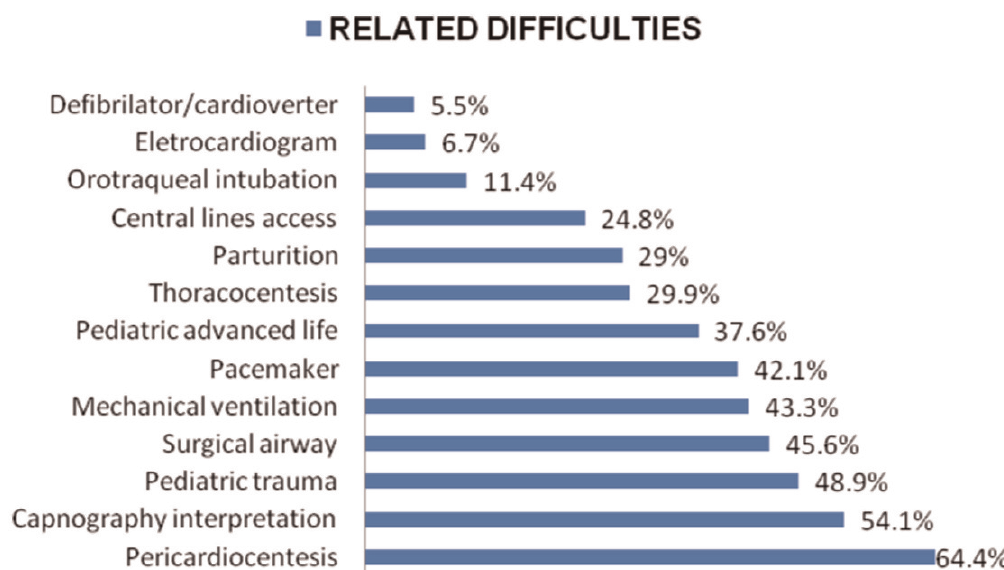
Figure 1 - The major deficiencies in procedures and equipment handling in prehospital care.